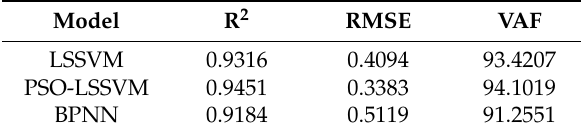
Table 8. Calculated R 2 , RMSE, and VAF indicators of the LSSVM, PSO-LSSVM, and BPNN